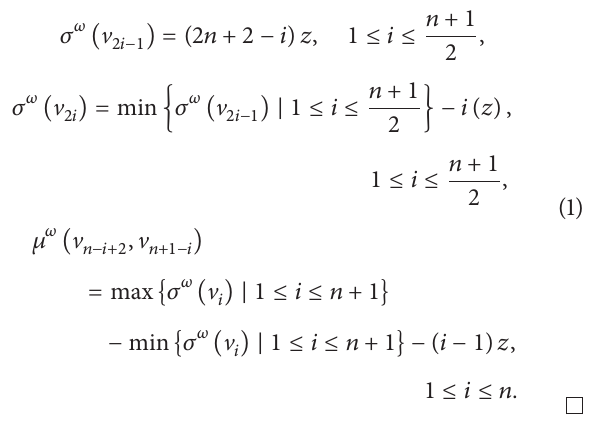
Figure 2: A fuzzy magic path graph: 𝑚 0 (𝑃) = 0.13